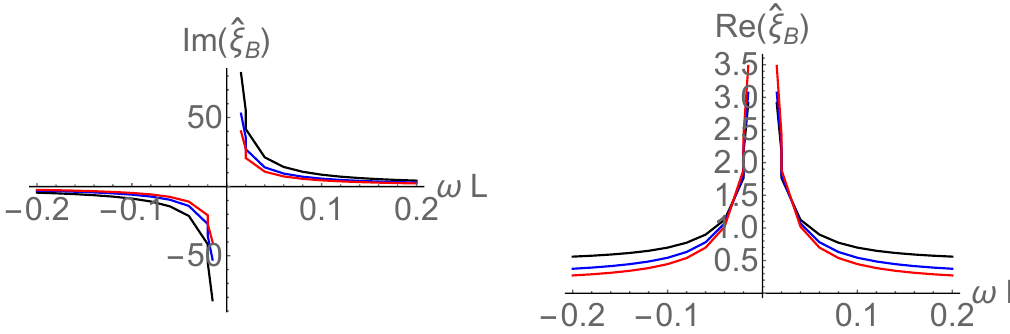
Figure 7. Solutions of the integrated two point function ^ (cid:24) B ( ! ) of the orientational perturbations at varying temperatures. These are y + = 2(red line) ; 3 = 2(solid blue line) ; 1(dashed